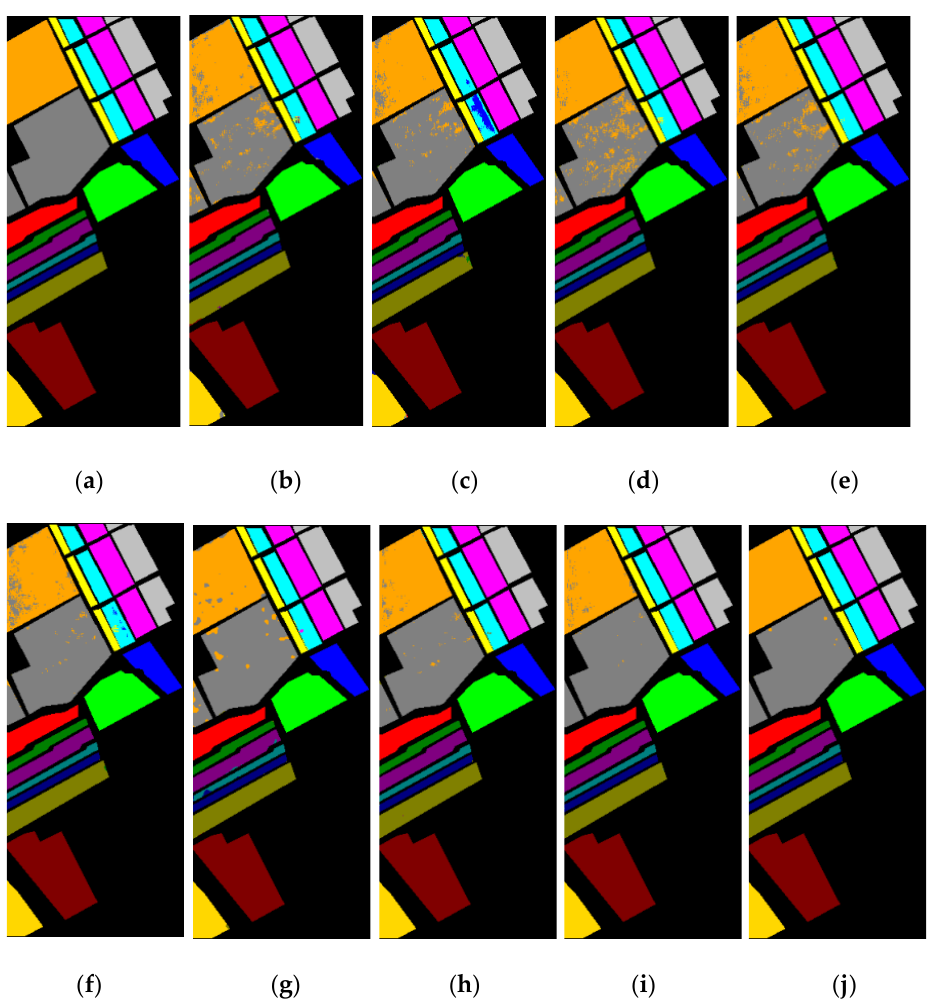
Figure 7. The classification results of Salinas dataset. ( a ) Ground Truth; ( b ) RBF-SVM; ( c ) EMP-SVM;